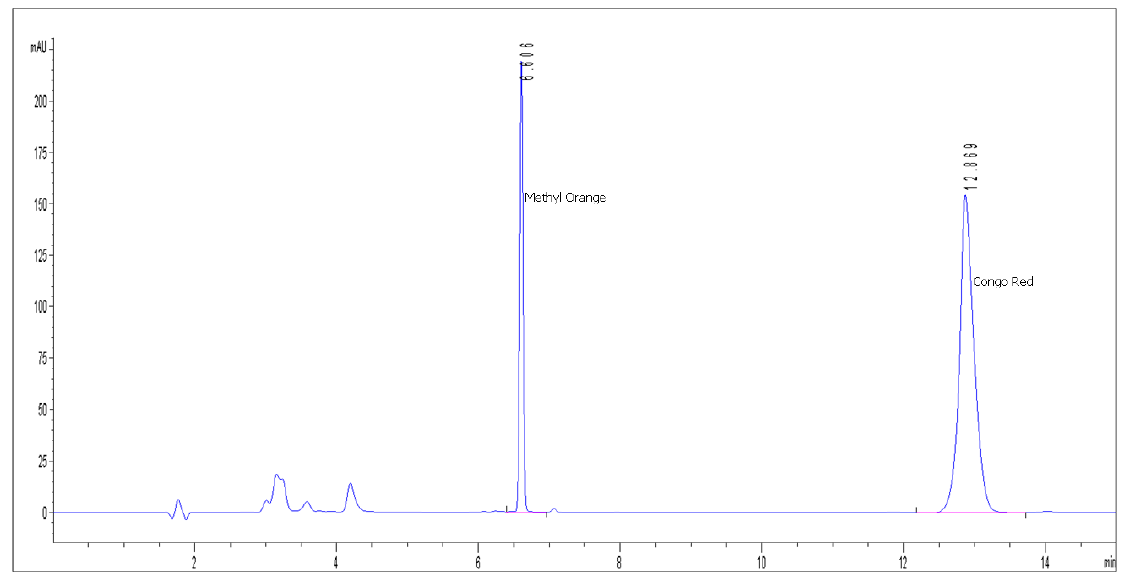
Figure 1. Chromatogram obtained from the analysis of Congo Red (CR) and Methyl Orange (MO). Method calibration curves were obtained using Congo Red and Methyl Orange aque- ous solutions of: 0.1, 0.2, 0.5, 1, 2.5, 5, and 10 mg/L (Figures S3 and S4).